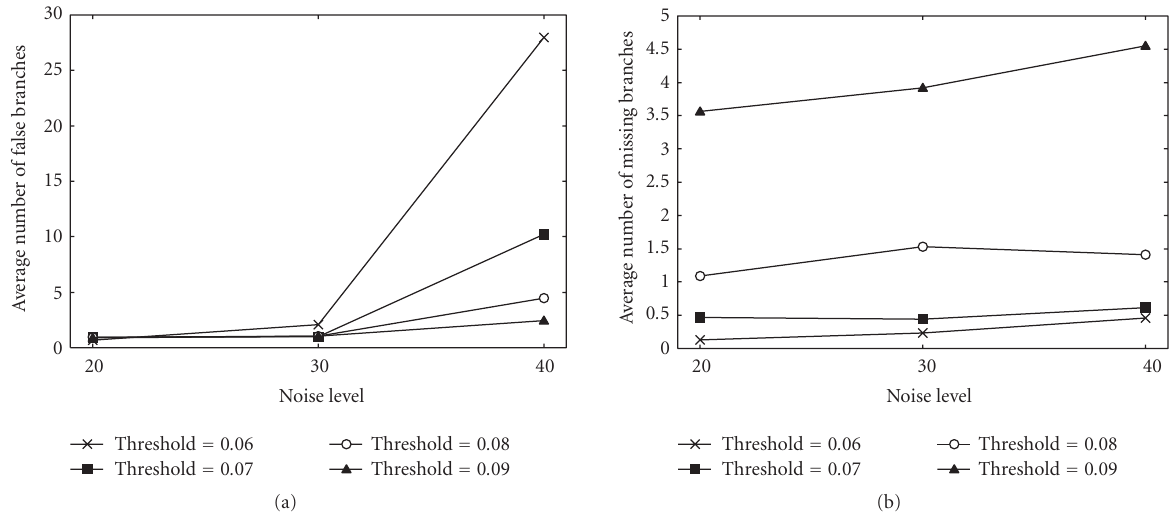
Figure 7: Average number of false (extra) branches and missing branches of the phantom evaluated by graph representation of the segmentation results. The false branches and missing branches were counted manually. (a) A total number of false branches (false positives). (b) A total number of missing branches (true negatives).